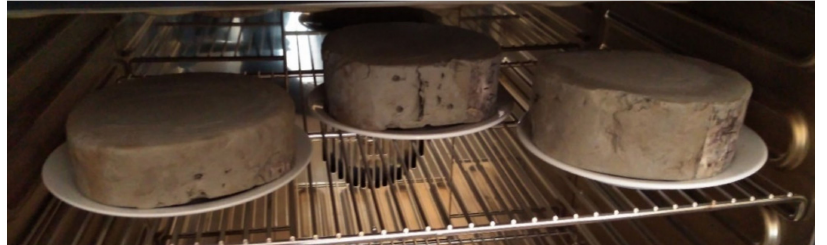
Figure 6. Drying of the drill core samples at T = 105 ◦ C in a lab